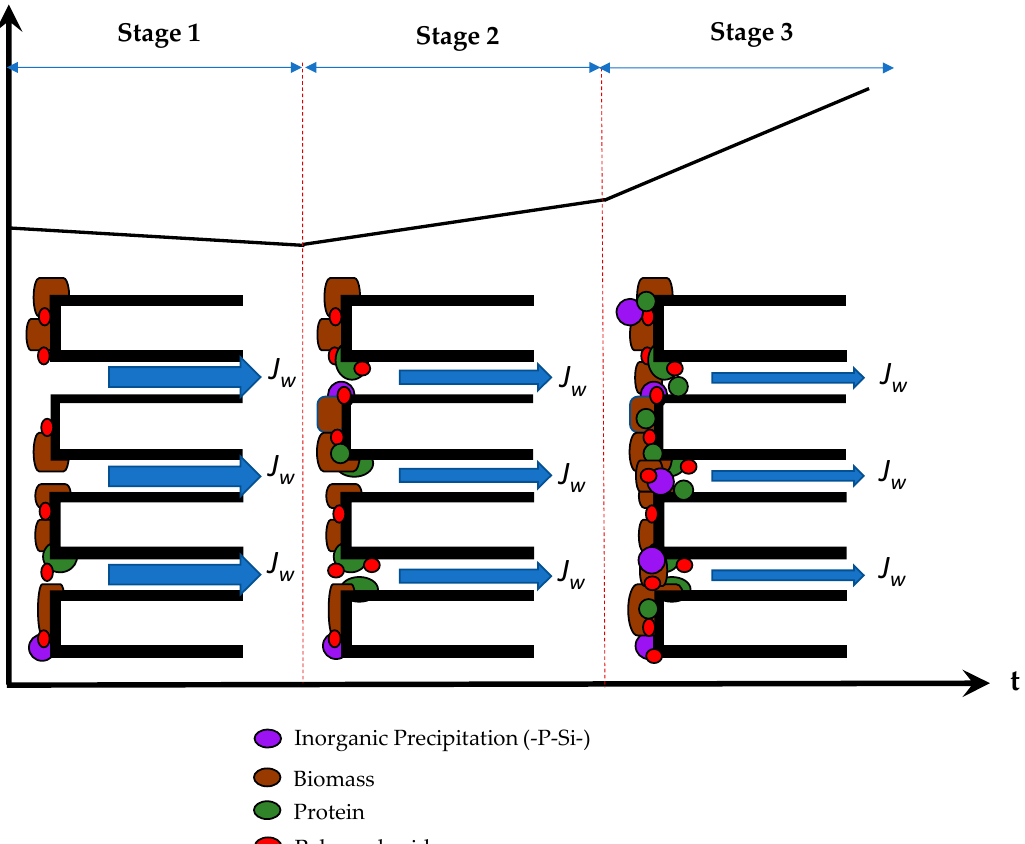
Figure 8. Behavior of foulants in AnMBR for high-rate POME treatment.